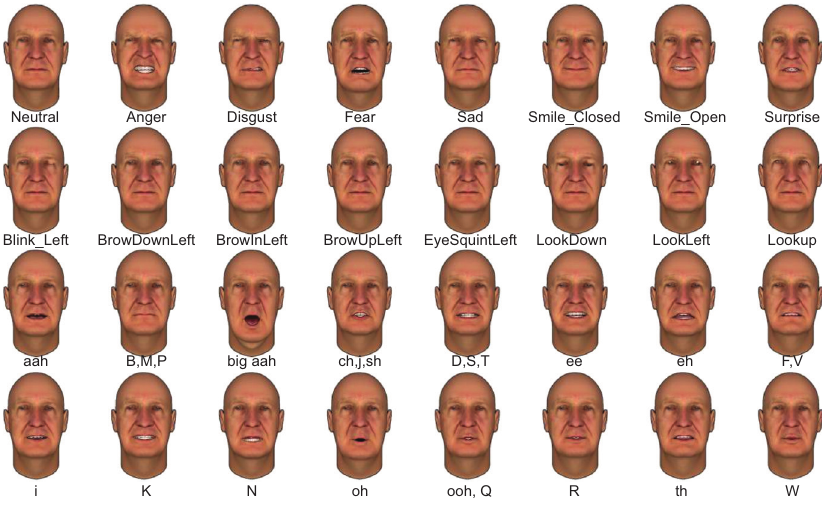
Figure 6. Facial Expression Morph